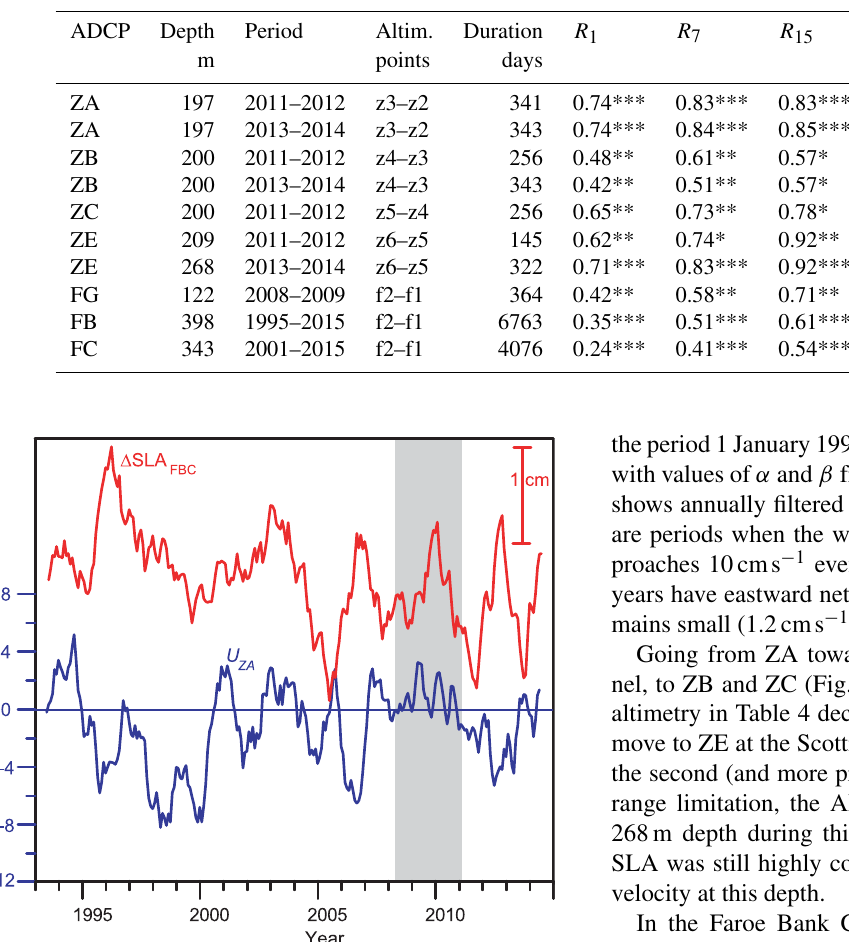
Table 4. Correlation ( R ) and regression ( α and β ) coefficients between eastward velocity at selected depths within the Atlantic layer at seven ADCP sites and SLA difference between pairs of altimetry points. Correlation coefficients are shown for daily ( R 1 ), weekly ( R 7 ), and 15-day ( R 15 ) averaged data. The regression coefficients are based on weekly averaged data and according to Eq. (1). Where the ADCP site was close to midways between two neighbouring altimetry points, those points were used. Otherwise, we used the altimetry pair that gave the highest correlation for weekly averaged data. The two bottom lines are based on several deployments.